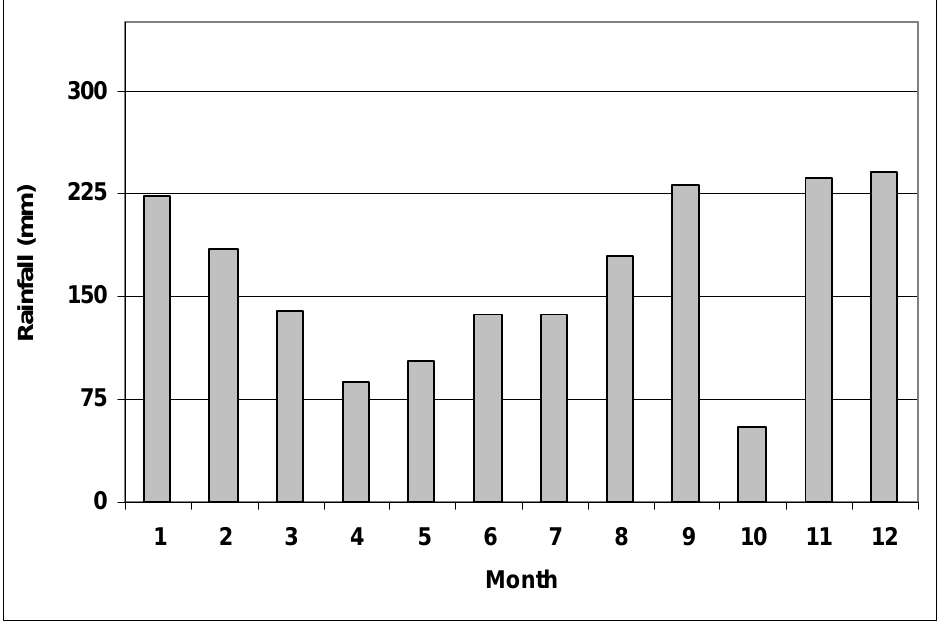
Figure 2. The mean annual rainfall of Rize region during the period of 1975 to